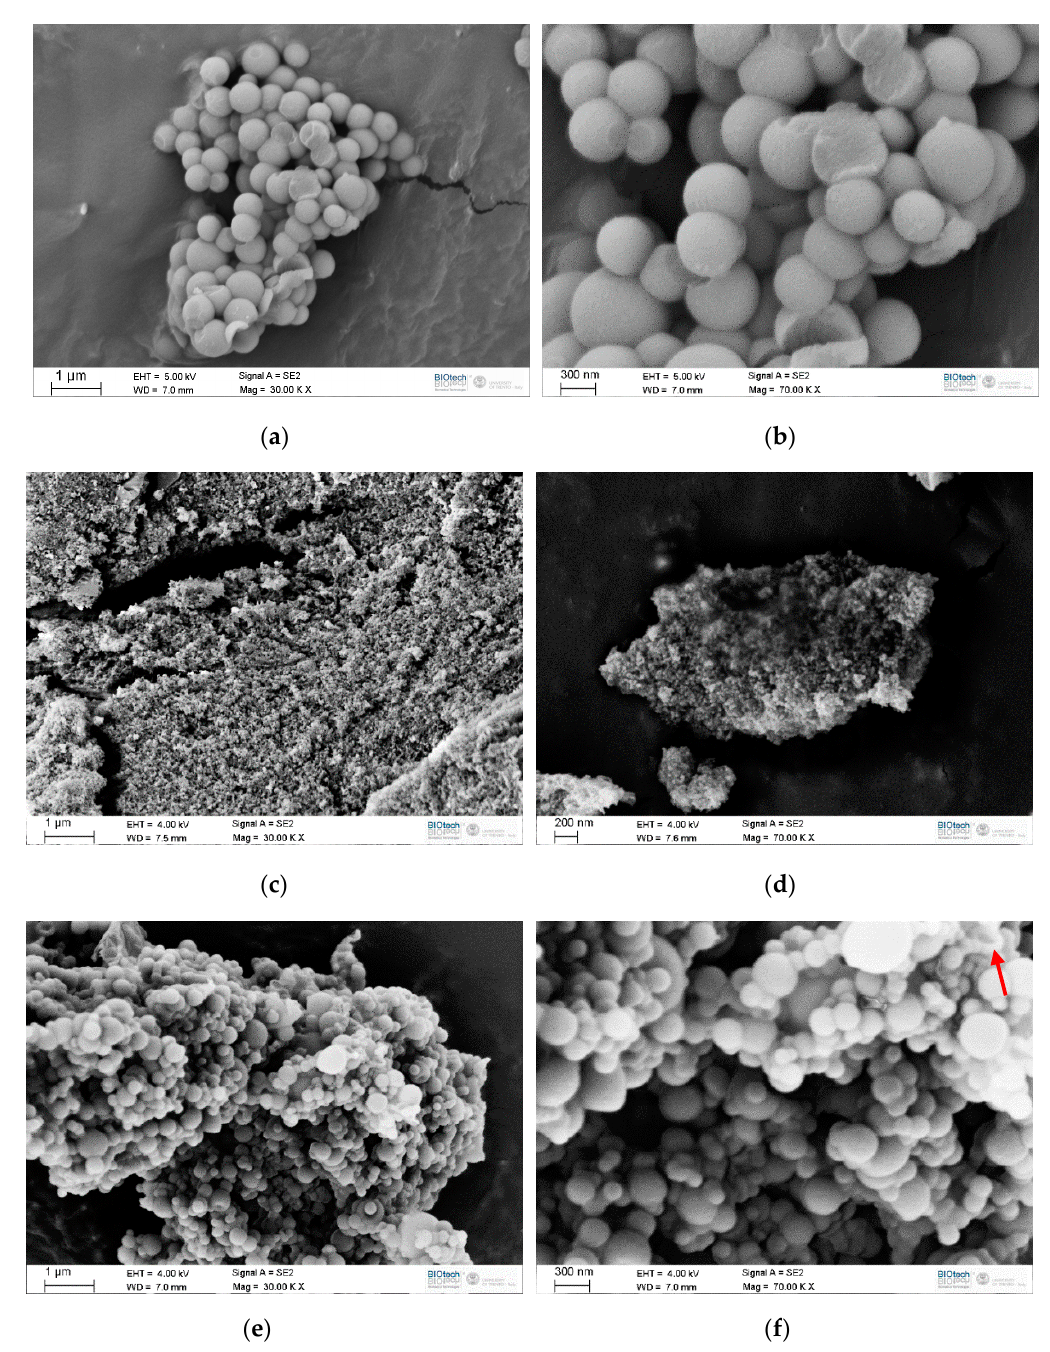
Figure 2. SEM micrographs of the prepared samples. ( a , b ) Si, ( c , d ) MC1, ( e , f ) MC2.